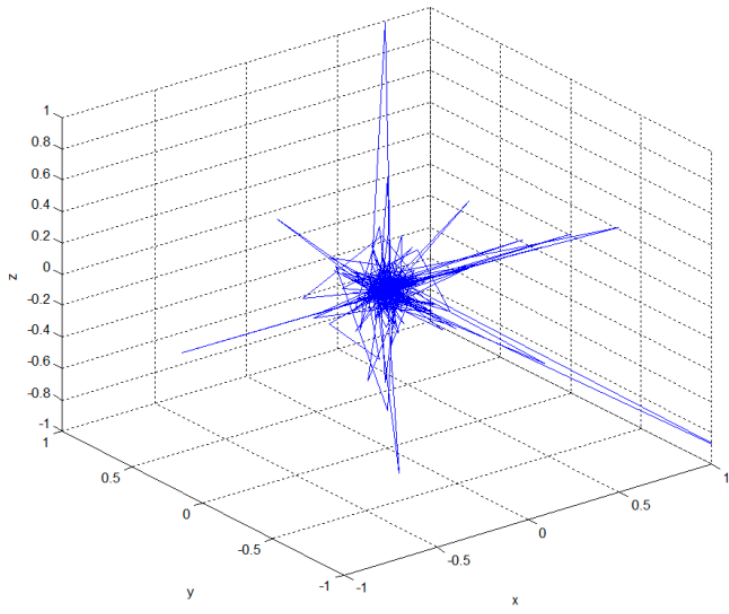
Figure 3. A 3D L é vy flight of 500 steps with (0, 0, 0) as starting point. Figure 3. A 3D Lévy fl ight of 500 steps with (0, 0, 0) as starting point. The standard version of CS mimicking cuckoo migration using L é vy flights has been customized so that it manages to achieve a balance between exploration and